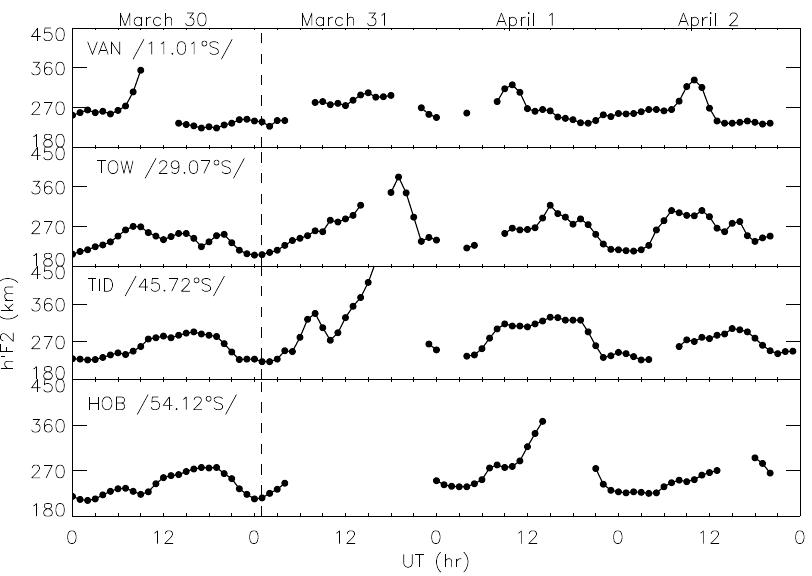
Fig. 11. One hour interval virtual F region height ( h 0 F) adopted from ionsonde data recorded at the four stations (Venamo, Townsville, Tidbinbilla, and Hobart) during 30 March to 2